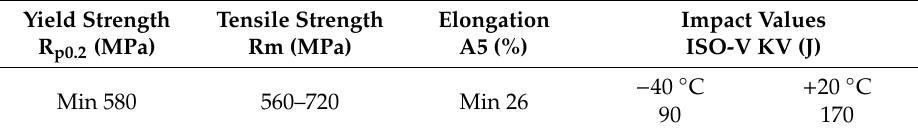
Table 4. Mechanical properties for the filler material with E 50 4 B 4 2